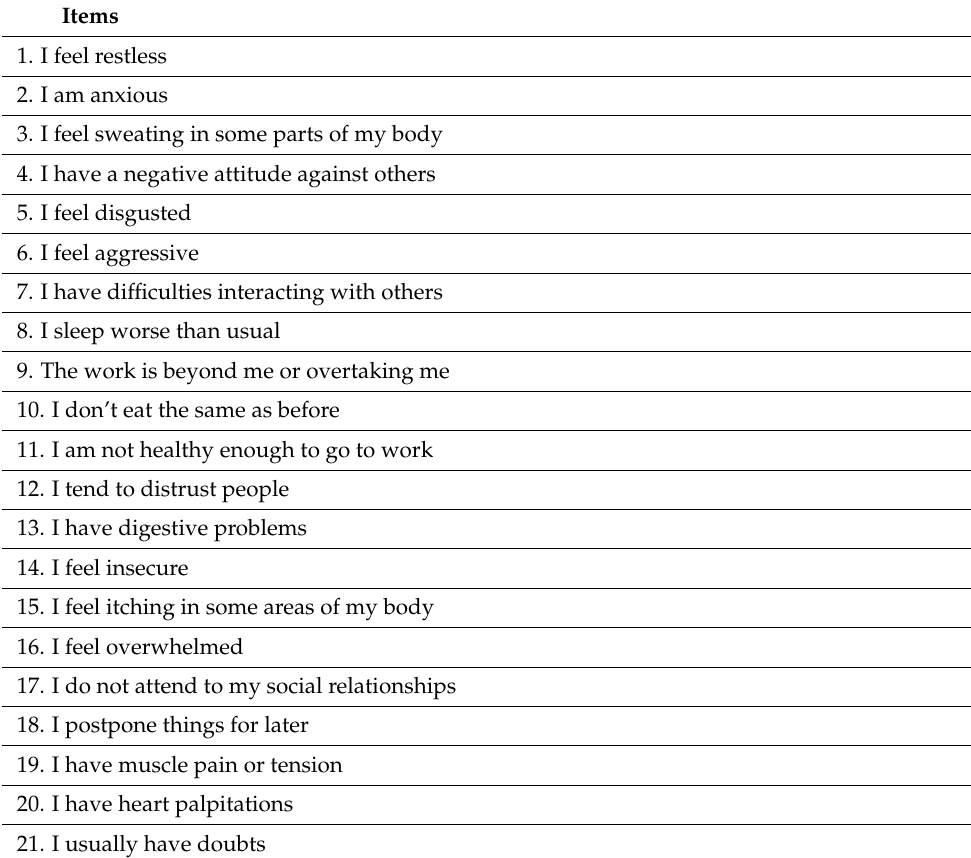
Table A1. Version of the Stress Factors and Manifestations Scale (English